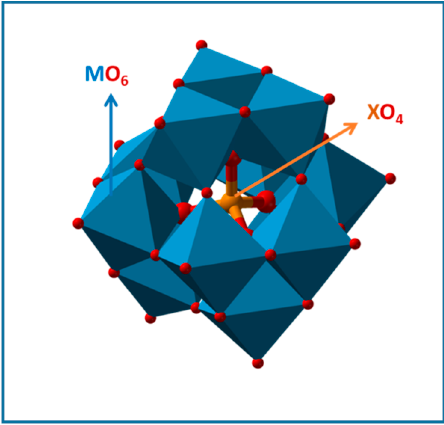
Figure 10. Keggin structure of heteropolyacids.